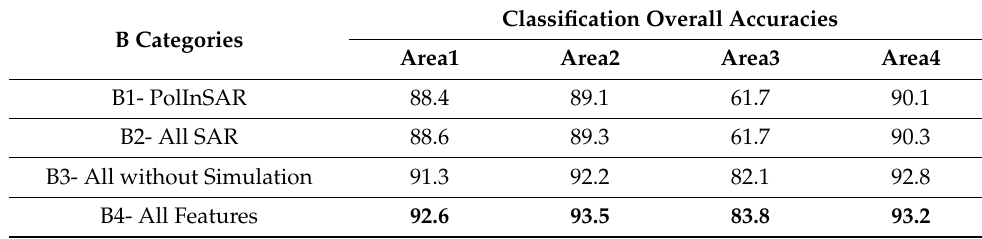
Table 9. Highest classification accuracies achieved in B